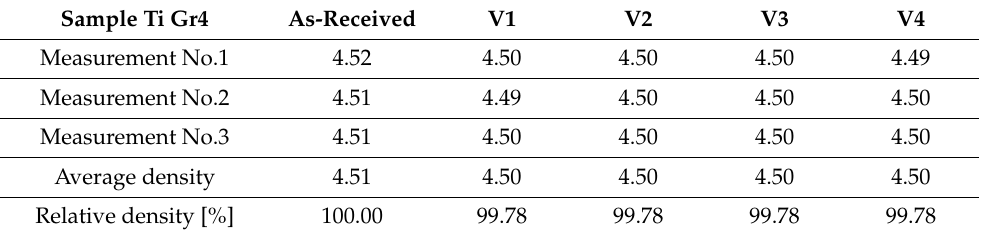
Table 7. Results of density measurements [g/cm 3 ] obtained for Ti Gr4 and Ti hp 99.99 performed using the Archimedes